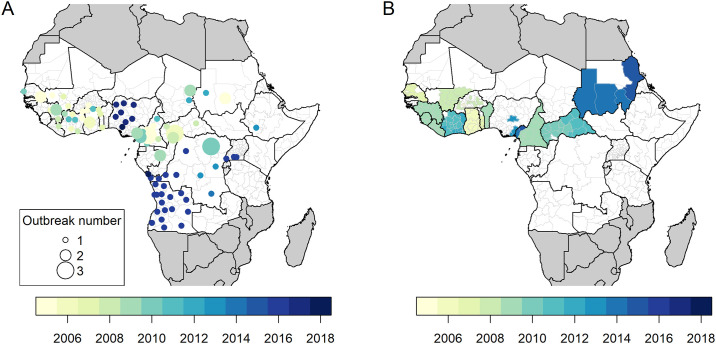
Occurrence of yellow fever outbreaks and preventive mass vaccination campaigns at the province level over the 2005–2018 period.(A) Yellow fever outbreaks. (B) Preventive mass vaccination campaigns. Maps were produced using GADM version 2.0.